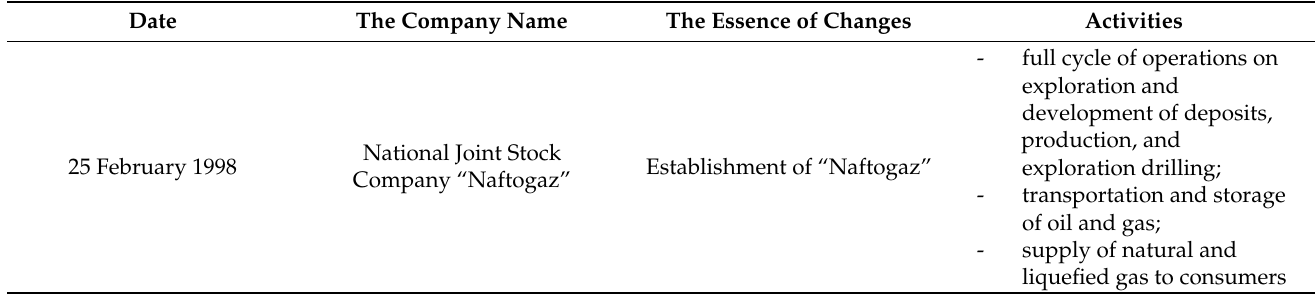
Table 3. Evolution of organizational forms of enterprises in the gas market of